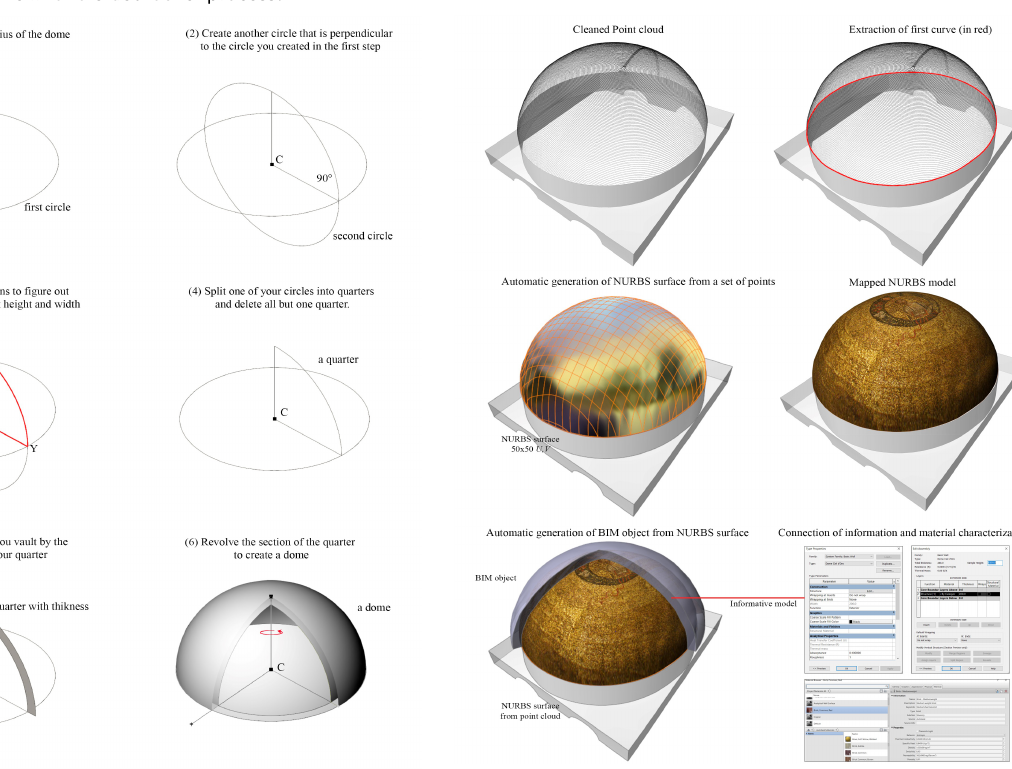
Figure 8. The traditional process: ‘how to model a dome’. Each step is not oriented to intercept the real shape of the 3D scans.